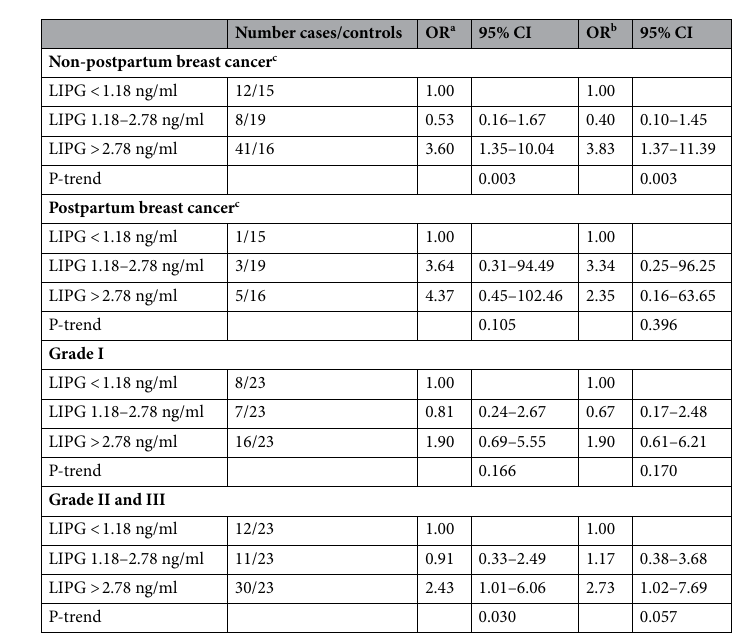
Table 6. LIPG and risk of breast cancer by time of diagnosis and grade. a Adjusted for age at diagnosis (cases) and age at interview (controls). b Further adjusted for age at menarche, parity, menopausal status, BMI, and family history of breast/ovarian cancer. c Among parous women